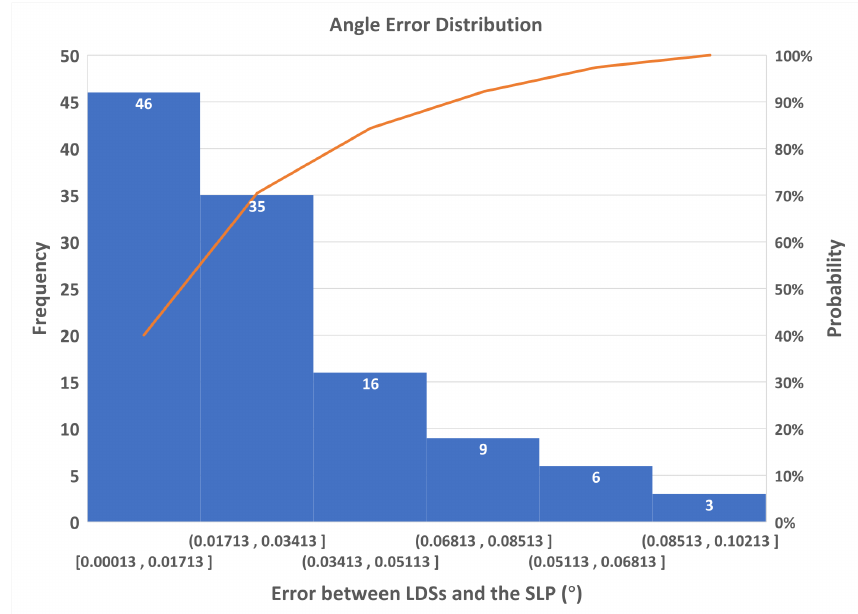
Figure 18. The distribution of the calibration